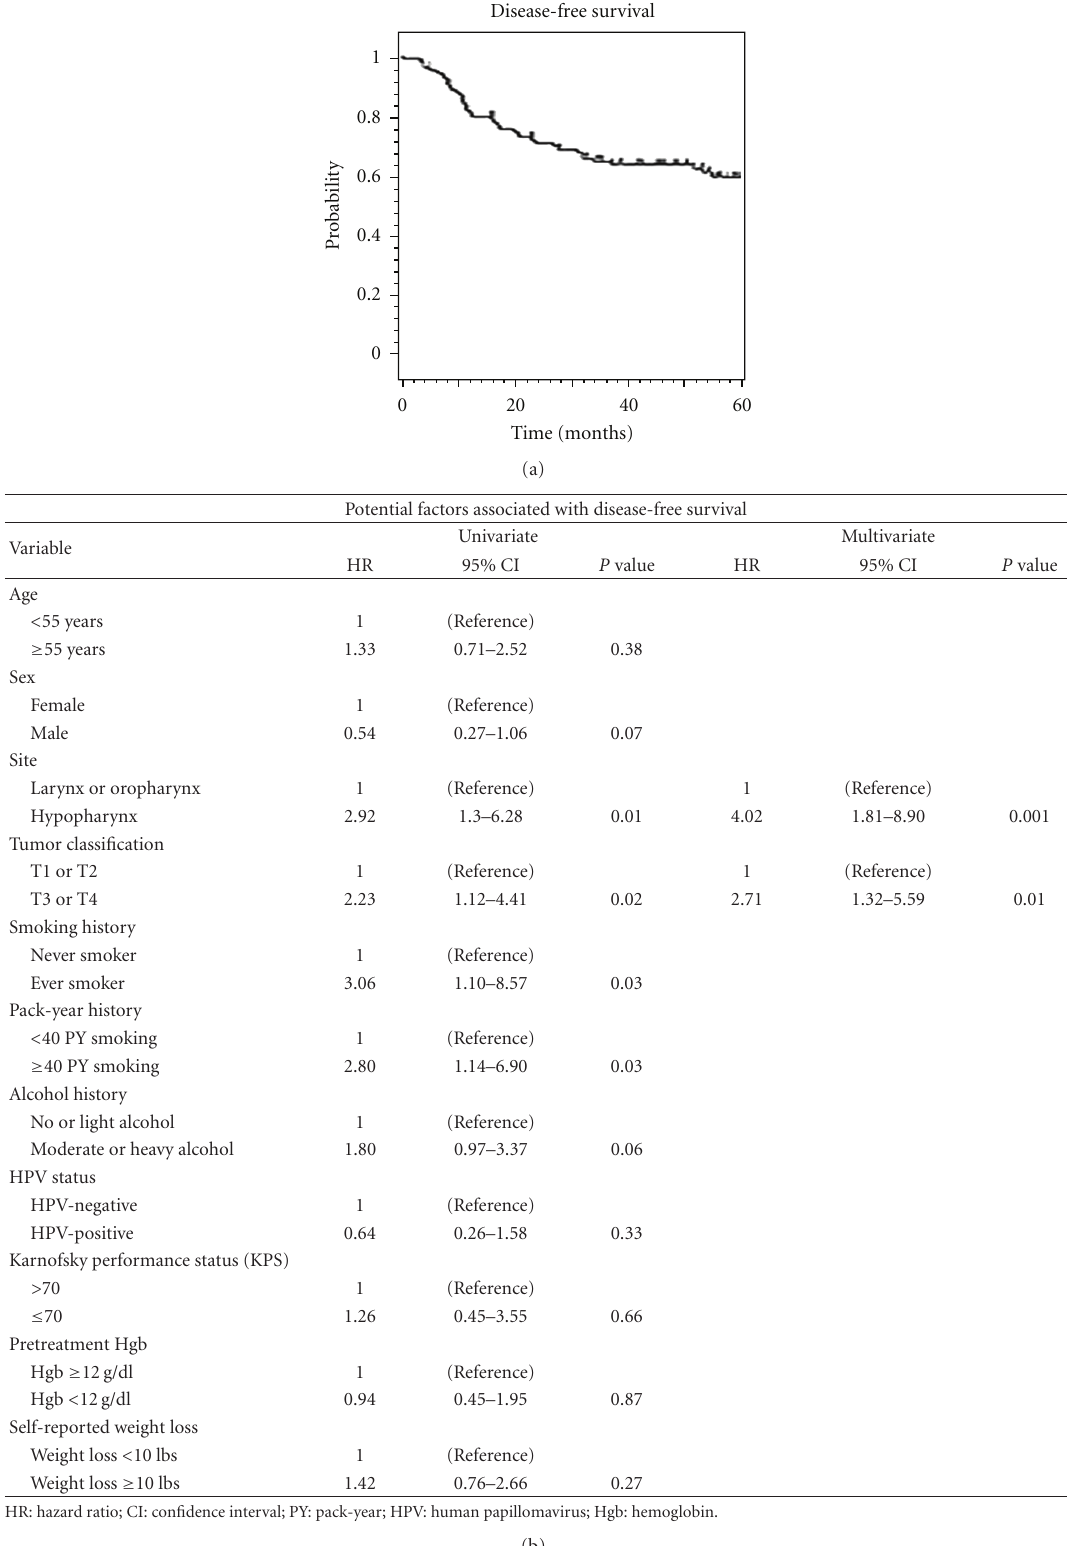
Figure 3: (a) Kaplan-Meier depiction of disease-free survival for all patients, (b) univariate and multivariate analyses of clinical characteristics potentially associated with disease-free